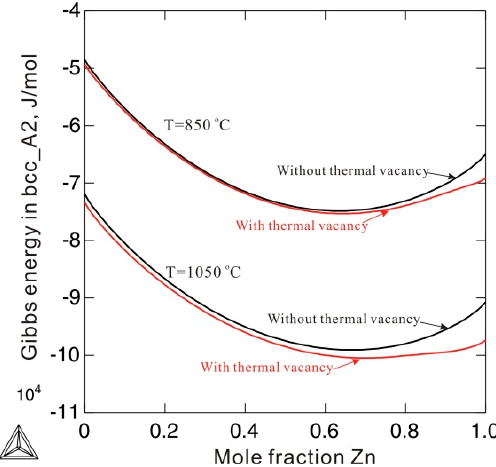
Figure 5. Comparison of molar Gibbs energy of the bcc_A2 phase with (red solid lines) and without a thermal vacancy (black dash lines) in an Ni-Zn binary system at 850 °C and 1050 °C.